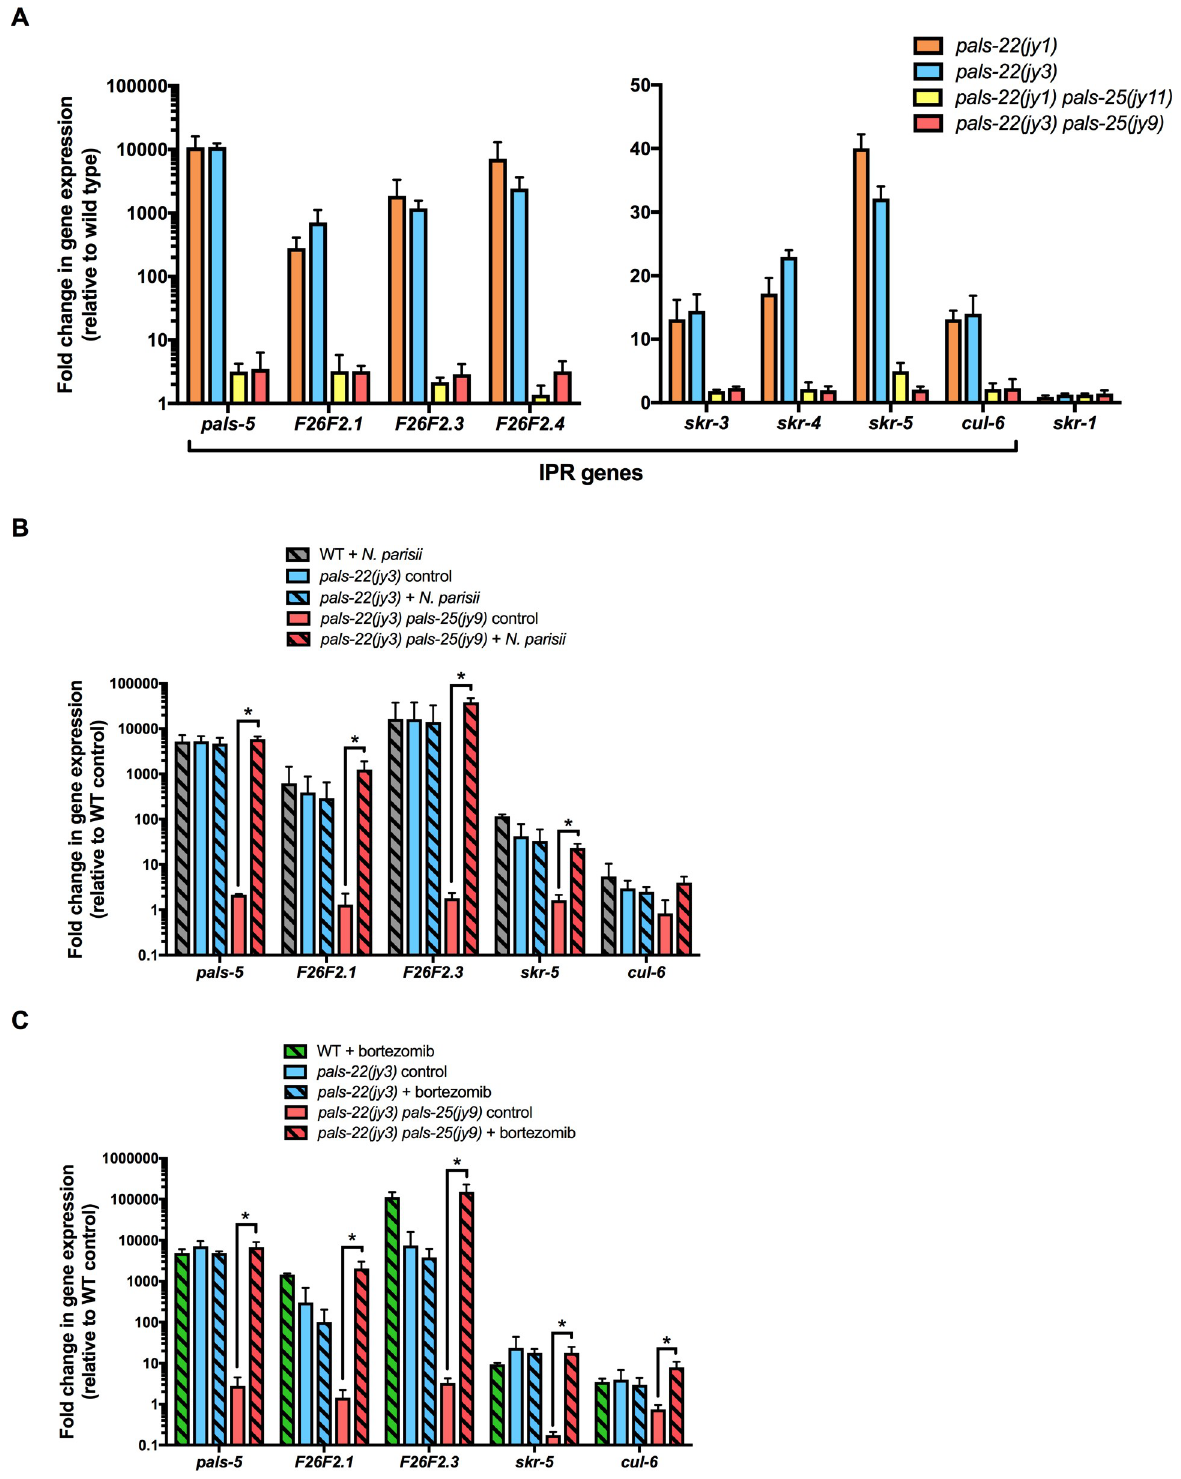
Fig 2. pals-25 is required for increased IPR gene expression in pals-22 mutants, but not for IPR induction in response to infection or proteasome inhibition. (A) qRT-PCR measurement of gene expression in pals-22 and pals-22 pals-25 animals, shown as the fold change relative to wild-type control. (B-C) qRT-PCR measurement of IPR gene expression in pals-22(jy3) and pals-22(jy3) pals-25(jy9) animals following 4 hours of infection with N . parisii (B) or treatment with the proteasome inhibitor bortezomib (C). For (A-C), results shown are the average of two independent biological replicates and error bars are SD. � p < 0.05 with Student’s t-test. https://doi.org/10.1371/journal.ppat.1007528.g002 PLOS Pathogens| https://doi.org/10.1371/journal.ppat.1007528 January14, 2019 6 /